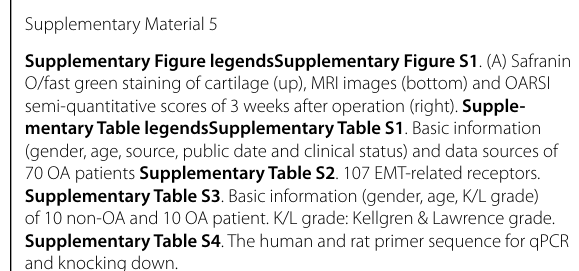
Supplementary Table S4 . The human and rat primer sequence for qPCR and knocking down.